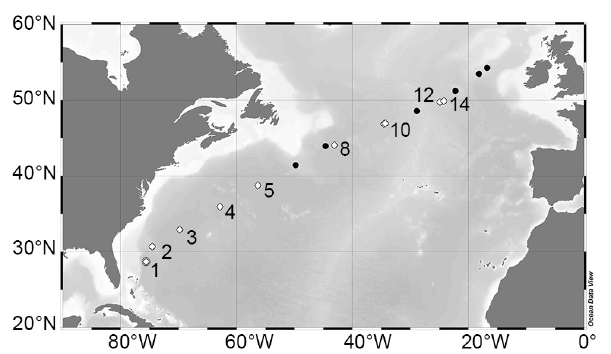
FIGURE 1 | Leg 8 NICO cruise transect in the North Atlantic Ocean. Bathymetric map depicting stations sampled during April of 2018. Modified dilution assays to simultaneously determine viral lysis and microzooplankton grazing rates of phytoplankton were performed at stations (numbered) indicated by white diamond symbols. Figure was prepared using Ocean Data View version 4 (Schlitzer,